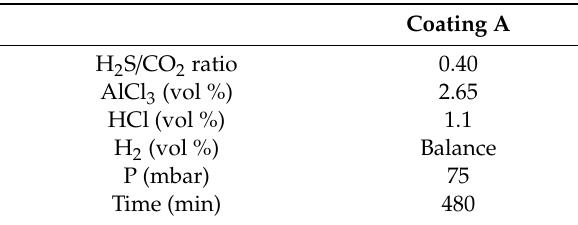
Table 3. Deposition conditions for Coating f.